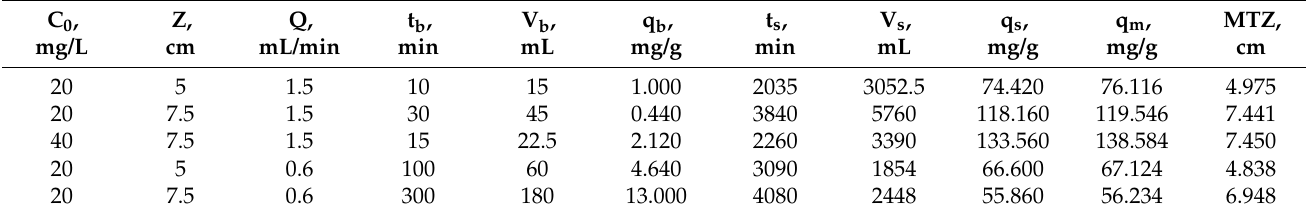
Table 1. Parameters of breakthrough curve for ethacridine lactate